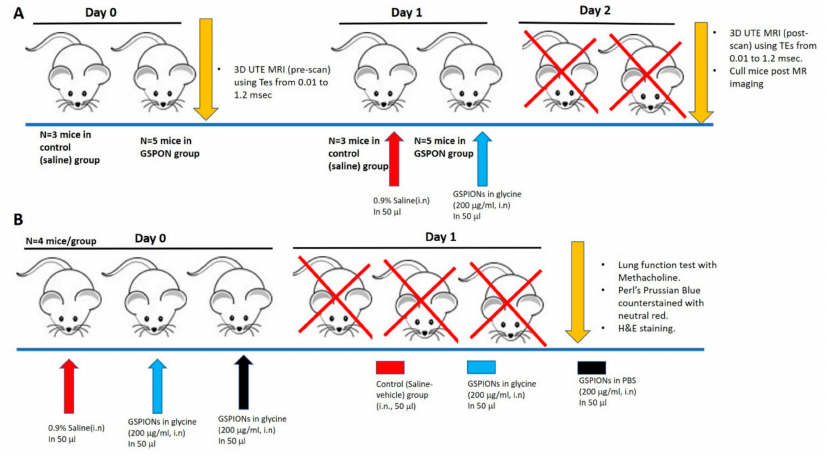
Figure 5. Study designs of experiments. ( A ). Study design for MR imaging experiment. Two groups